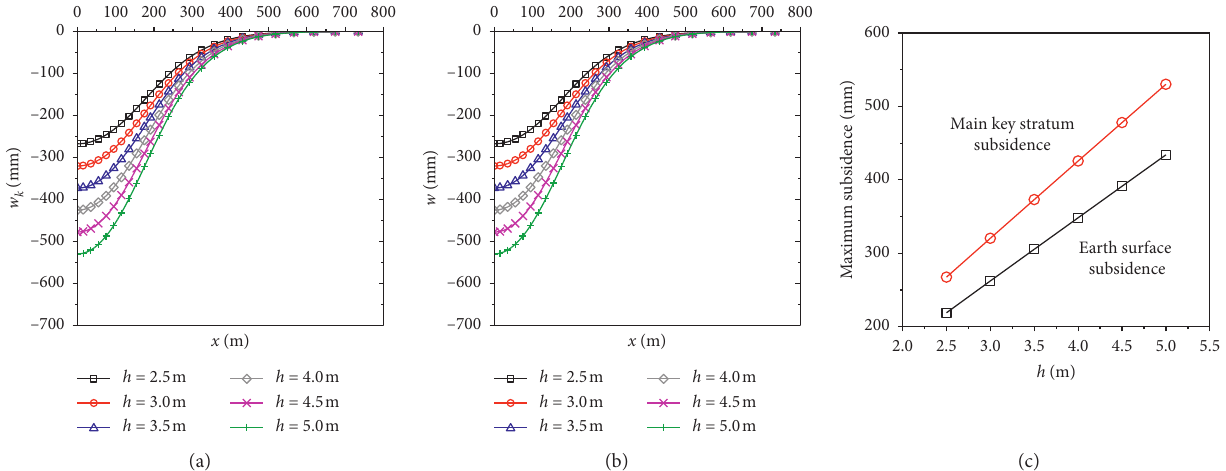
Figure 13: (a) Subsidence curve of main key strata, (b) surface subsidence curve, and (c) variation curve of maximum subsidence at different mining